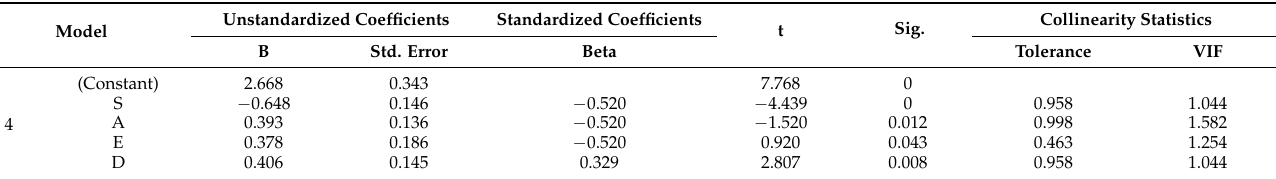
Table 8. Stepwise linear multivariation regression